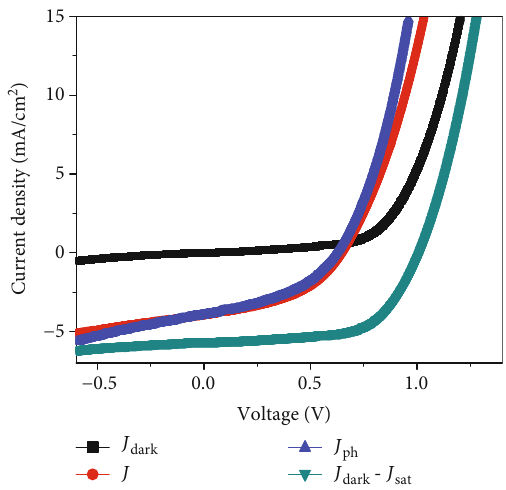
Figure 8: Measurements of the dark current, solar cell current, dark current minus solar cell current, and dark current minus reverse saturation current of the PCDTBT:PC BM solar cell processed 71 with 3% DIM and illuminated with solar illumination intensity of 40 mW/cm 2 in ambient air.